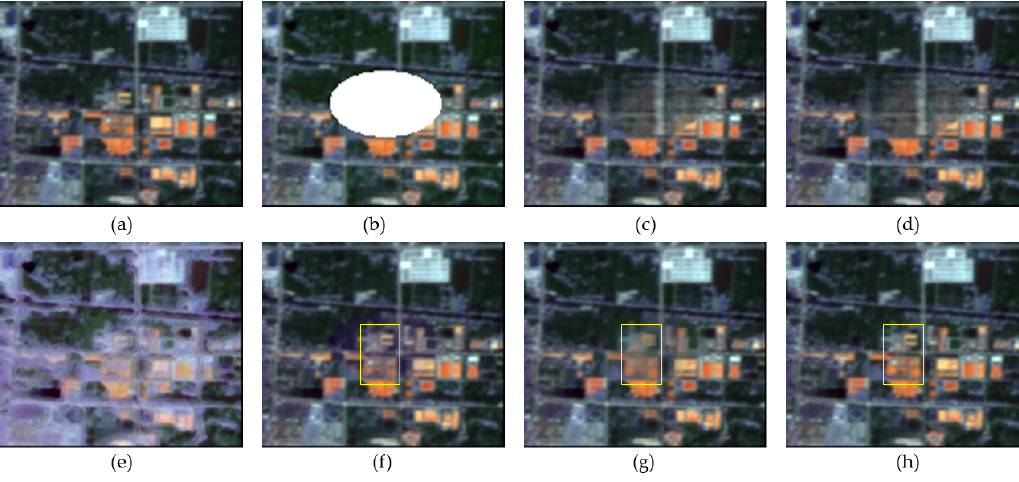
Figure 8. ( a )–( h ) Detailed regions clipped from Figure 7a–h. Table 2. The PSNR, SSIM, MS-SSIM, IW-SSIM, FD, and CE of the first simulated experimental results. The values of the highest accuracies are in